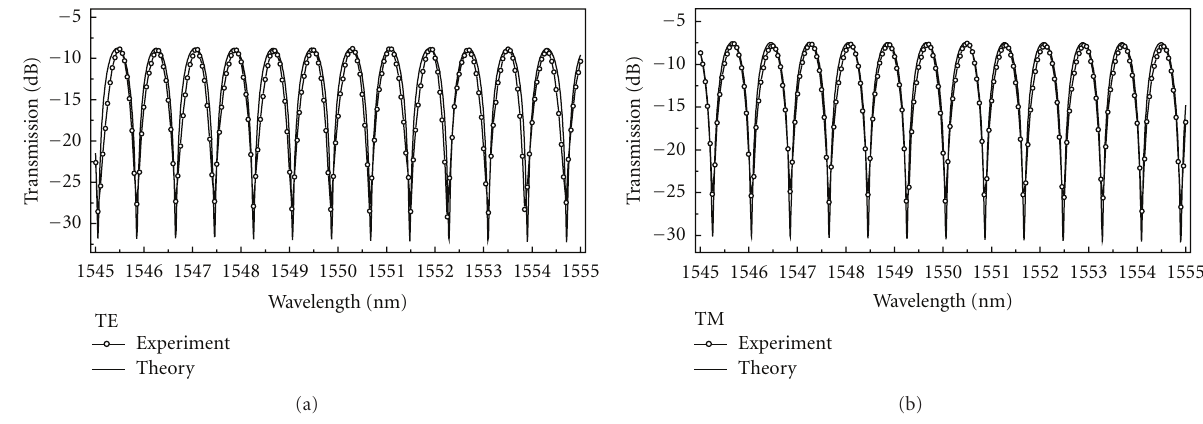
Figure 4: The measured and the simulated transmission spectra over a 10 nm span for TE mode (a) and TM mode (b).